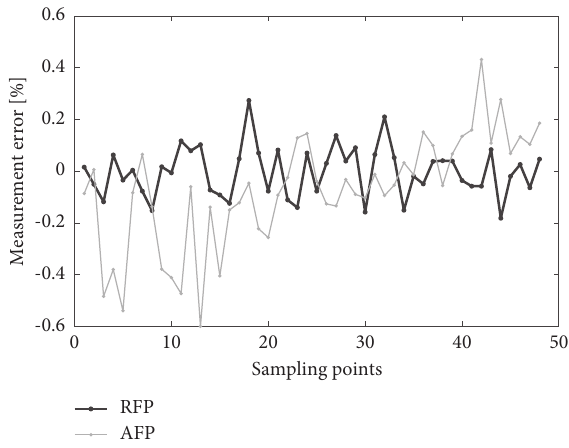
Figure 8: Values of AFP and RFP measurement error